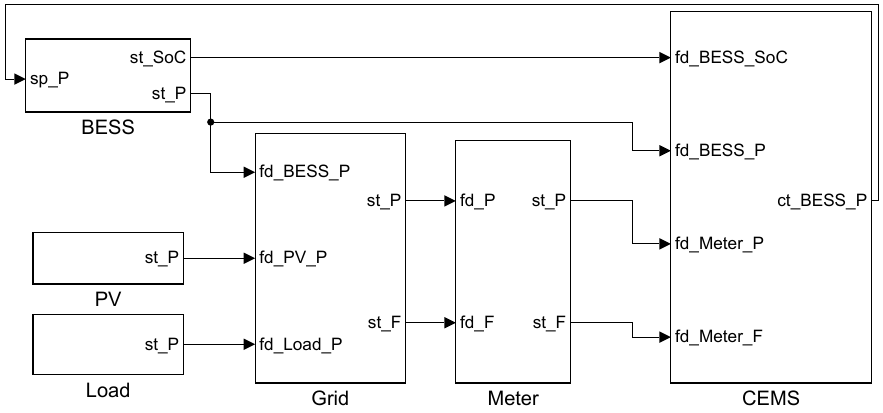
Figure 11. Structure of the CEMS-Simulink model generated.